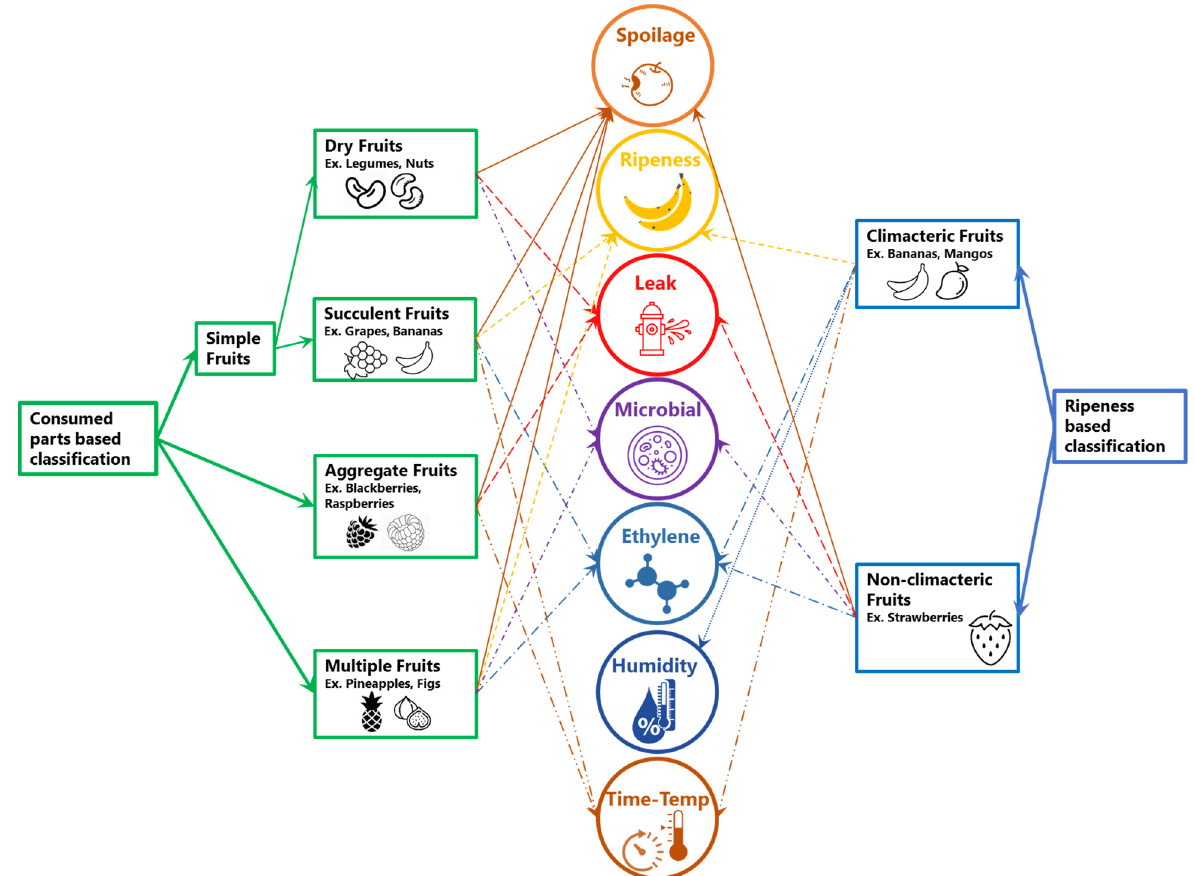
Figure 1. Fruit classification hierarchy and its relevance to different freshness parameters [19,20].